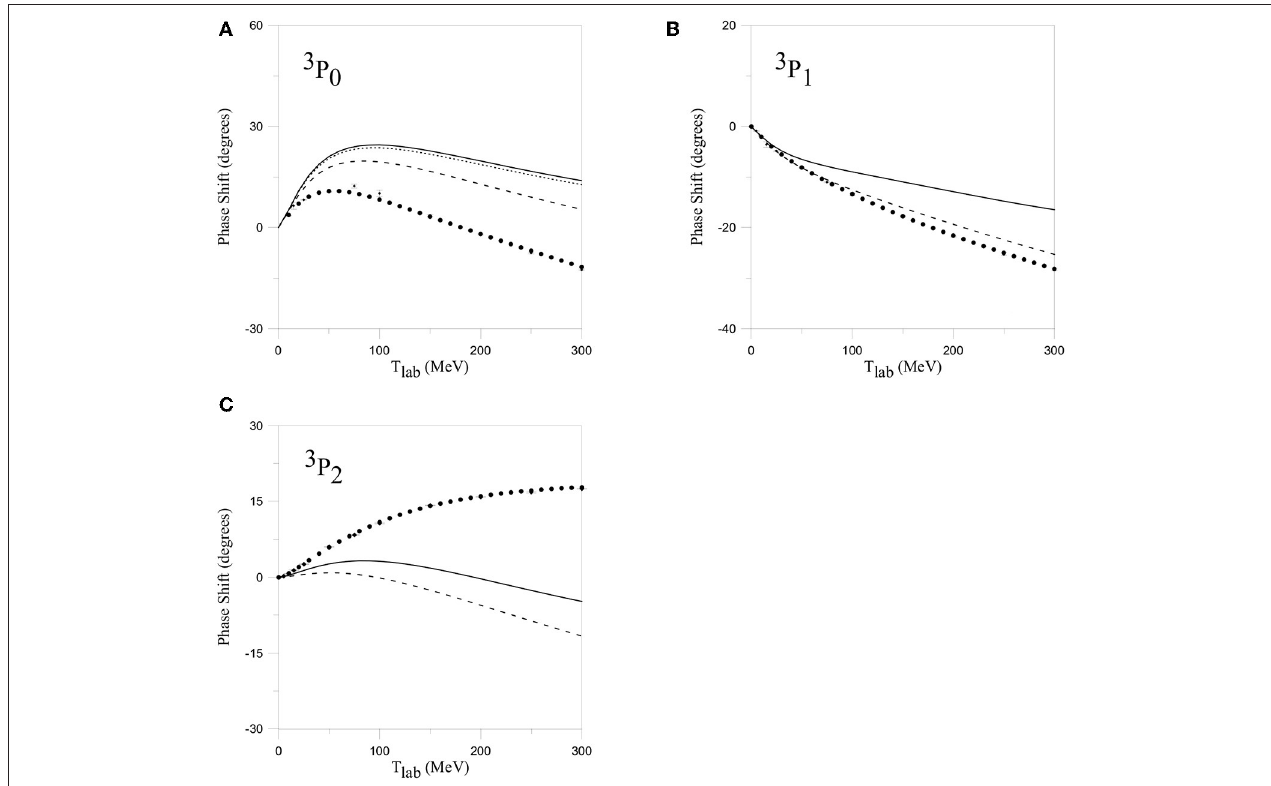
FIGURE 6 | NN 3 P J phase-shifts. (A) Same meaning as in Figure 4A . (B,C) Dashed line corresponds to the result with NN channels only, and the solid line includes NN and N 1 channels. Reprinted figure with permission from Entem et al. [52] Copyright (2000) by the American Physical